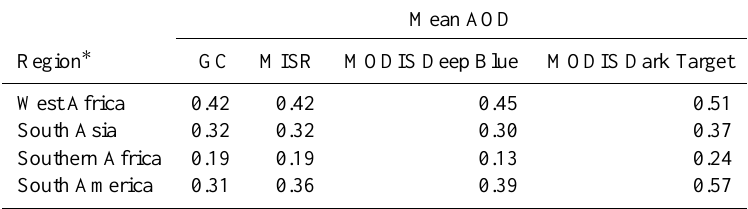
Table 3. Comparison of the simulated versus observed (OMI) UVAI values for the biomass burning regions in the months examined. The base case corresponds to a simulation without BrC, while case 2 corresponds to a simulation including absorbing BrC. Base case Case 2 with BrC Region d n c Month Mean OMI UVAI r a Mean Bias b r Mean Bias West Africa 381 January 1.25 0.48 − 0.57 0.68 − 0.09 South Asia 280 April 0.34 0.46 − 0.32 0.66 + 0 . 0002 Southern Africa 184 July 0.66 0.09 − 0.97 0.63 − 0.22 South America 230 September 0.30 0.40 − 0.50 0.57 + 0 . 33